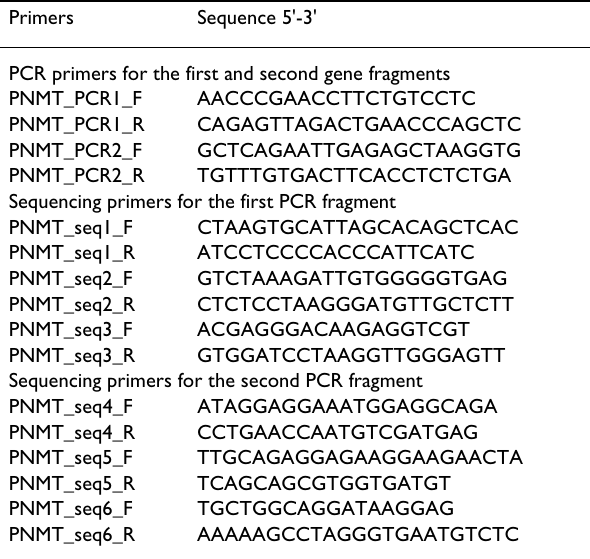
Table 1: PCR and sequencing primers for human PNMT gene